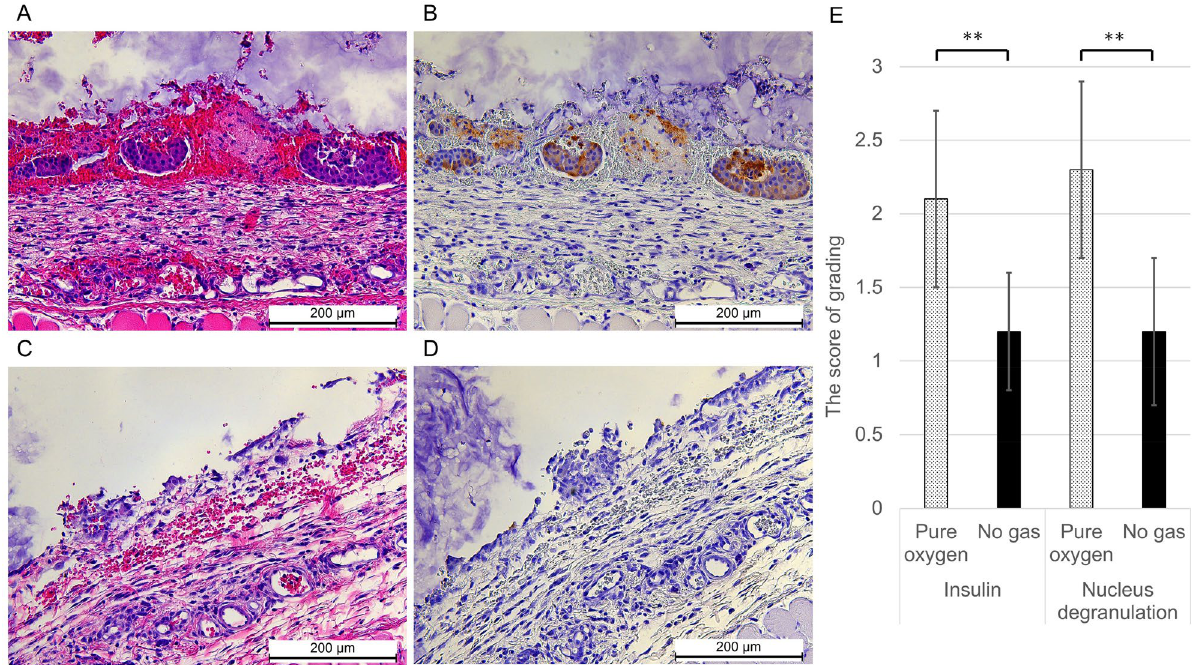
Figure 6. Immunohistochemical staining of transplanted islet grafts in the Pure oxygen and No gas groups. ( A – D ) Representative image of the graft islets of hematoxylin–eosin and insulin staining in the Pure oxygen group ( A , B ) and in the No gas group ( C , D ). Magnification: × 200, Scale bar: 200 μm. ( E ) Comparison of the scores of grading by the amount of insulin and the degree of nucleus degranulated. Both scores were significantly higher in the Pure oxygen group compared to the No gas group (2.1 ± 0.6 (n = 41) vs. 1.2 ± 0.4 (n = 24) in insulin grading, p < 0.01; 2.3 ± 0.6 (n = 41) vs. 1.2 ± 0.5 (n = 24) in nucleus grading, p < 0.01). **p < 0.01 (Student’s t test).